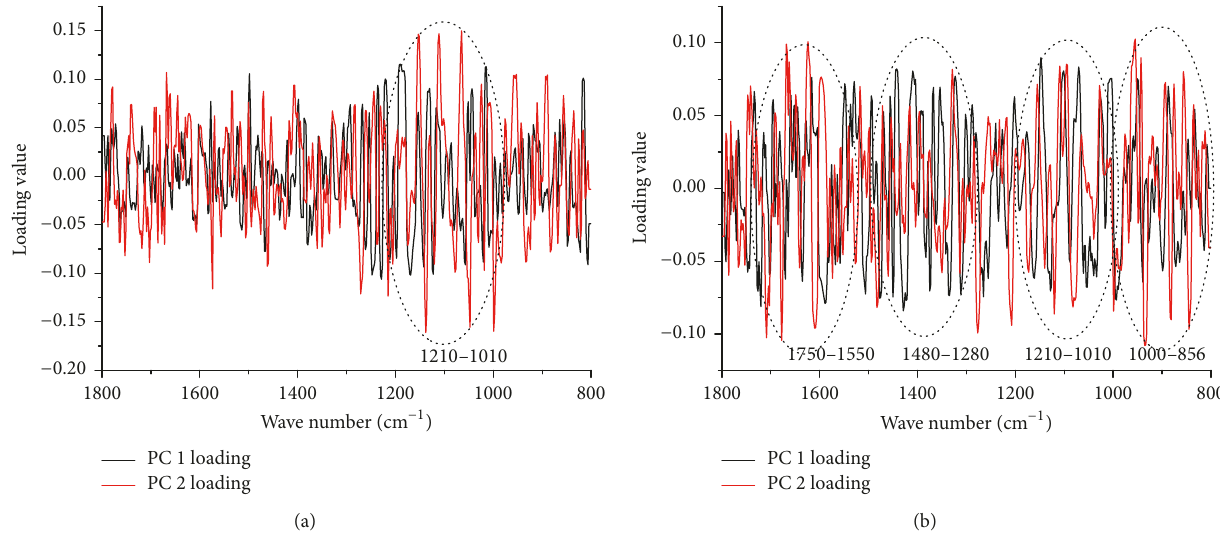
Figure 6: The loading plot of PC1 and PC2. (Description: (a) shows loading plot of the classification between different cultivation ages and (b) shows loading plot of the classification between different